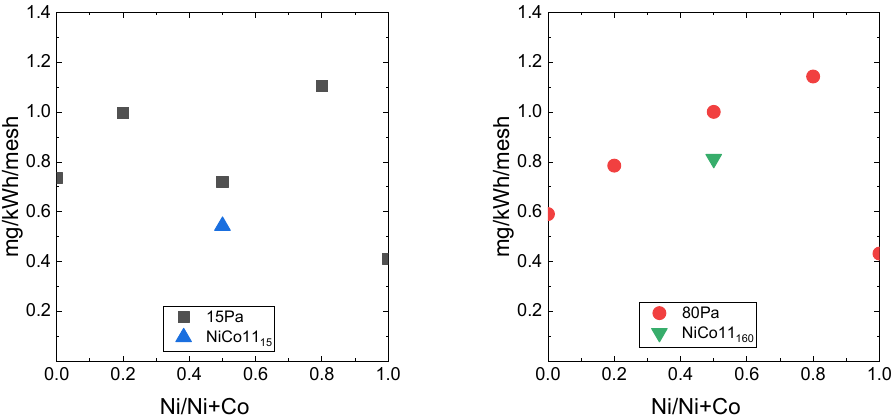
Figure 1. Oxide deposition rate per mesh as a function of the Ni/Co molar ratio of the hollow cathode material. Mesh weight: 0.46 g.